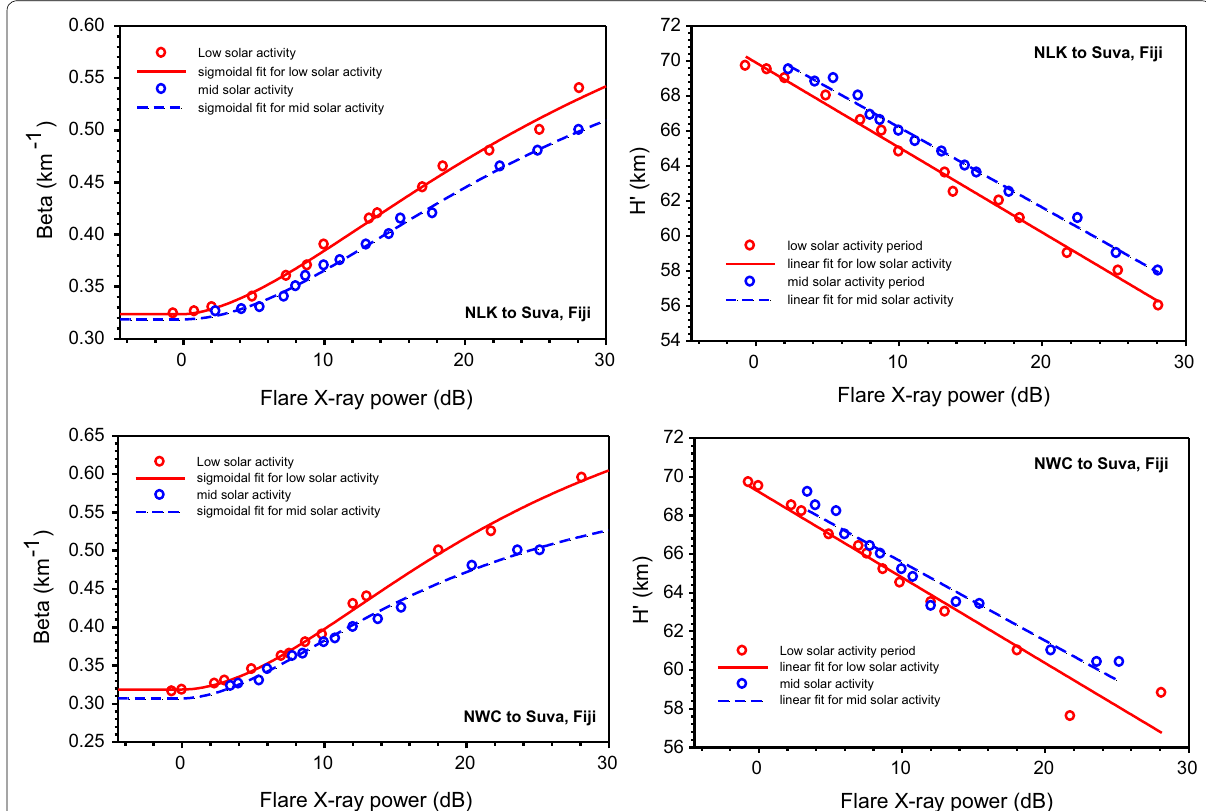
Fig. 7 Ionospheric D-region parameters H ′ and β , found as functions of solar X-ray flare power from the VLF amplitude and phase perturbations of NLK and NWC signals received at Suva during the periods of low- and mid-level (moderate) solar activity. The red points and best-fit lines corre- spond to low-level solar activity, while the blue points and best-fit lines correspond to mid-level (moderate) solar activity